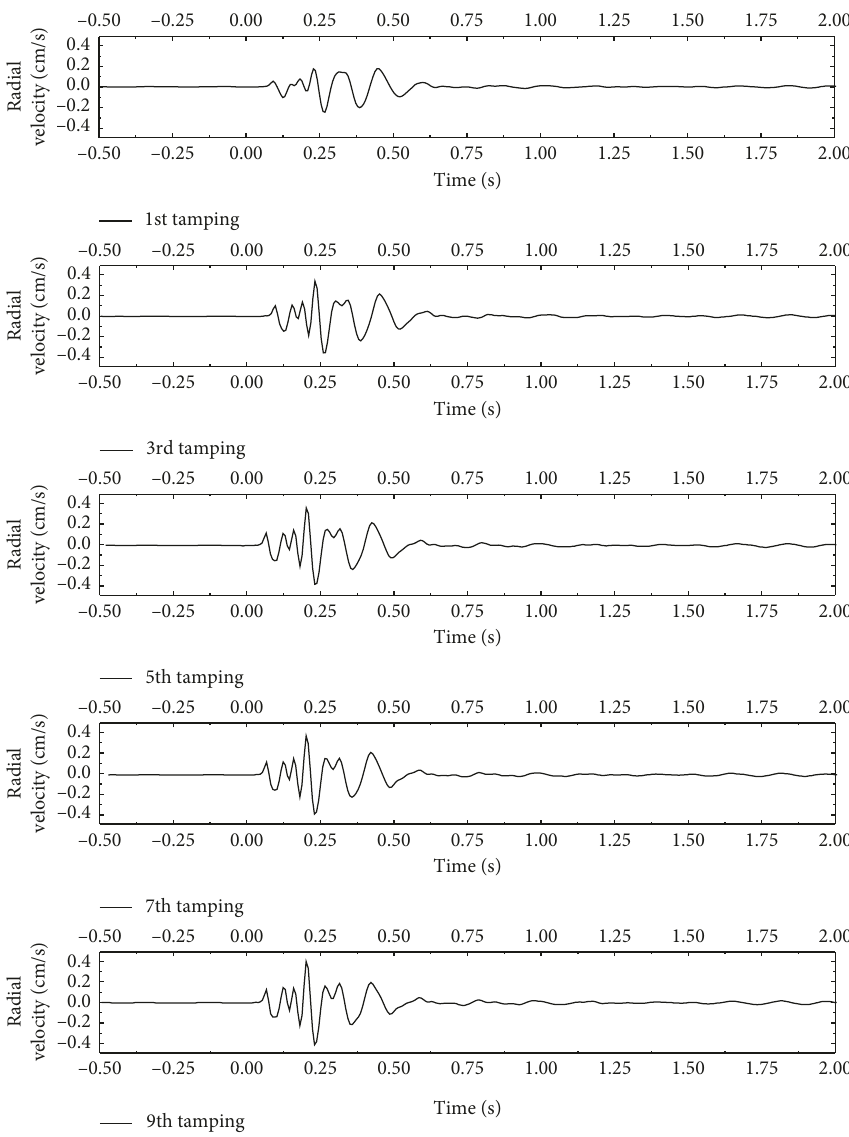
Figure 4: Radial vibration velocity histories at 80m distance under different times of